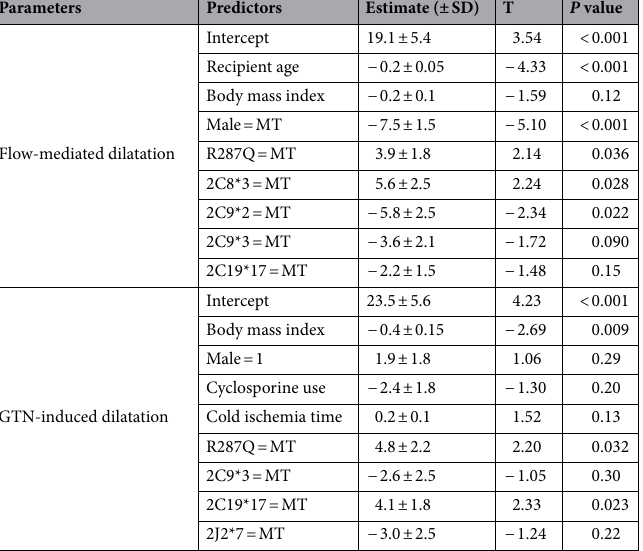
Parameters Predictors Estimate (± SD) T P value